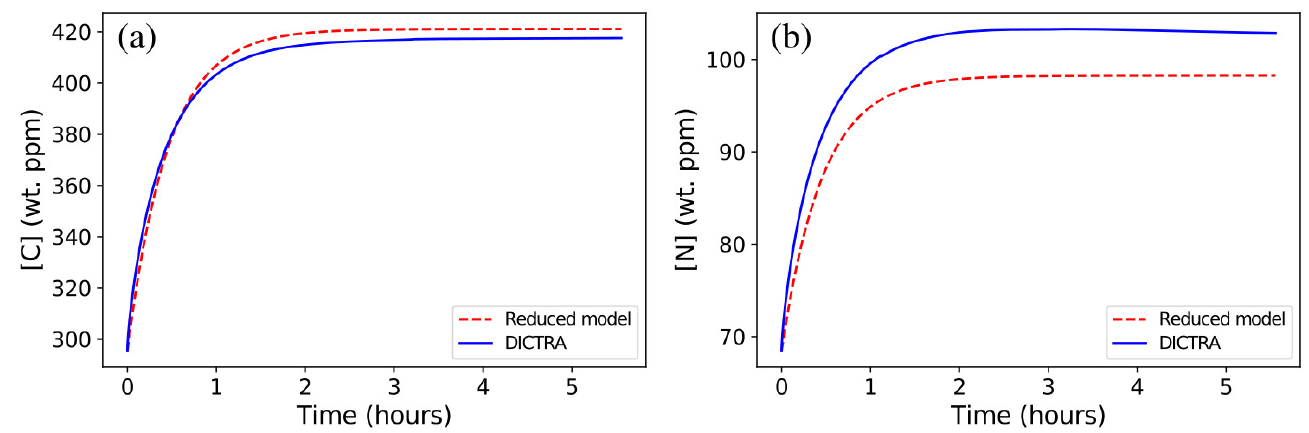
Figure 7. A comparison of the mean ( a ) C and ( b ) N contents in austenite ([C] and [N]) calculated using DICTRA (7-element calculation using TCFE9) and that obtained from the reduced model (Equations (4) and (5)) for isothermal holding at 1473 K.